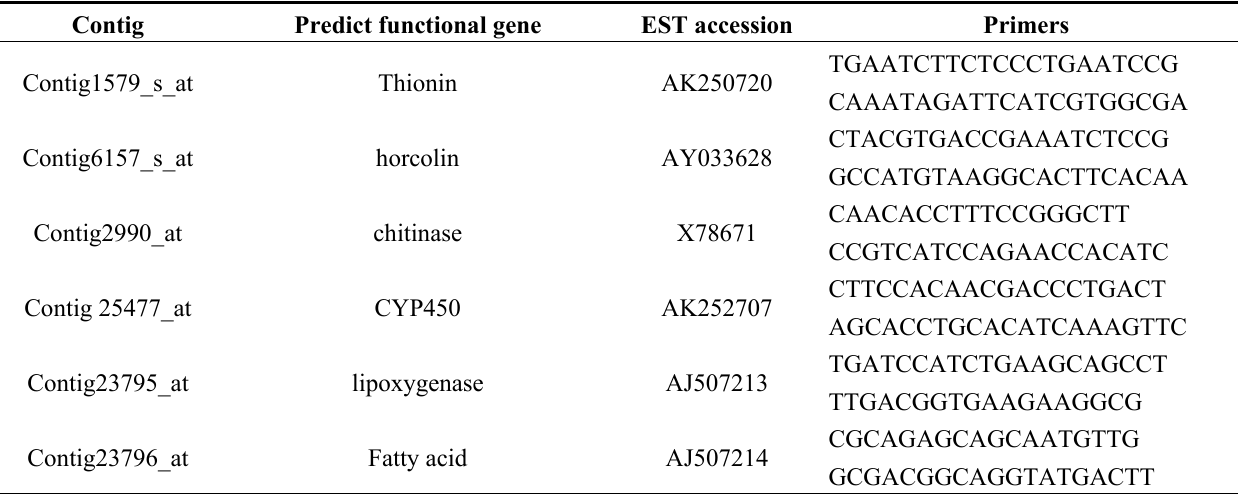
Table 4. The PCR primers for selected